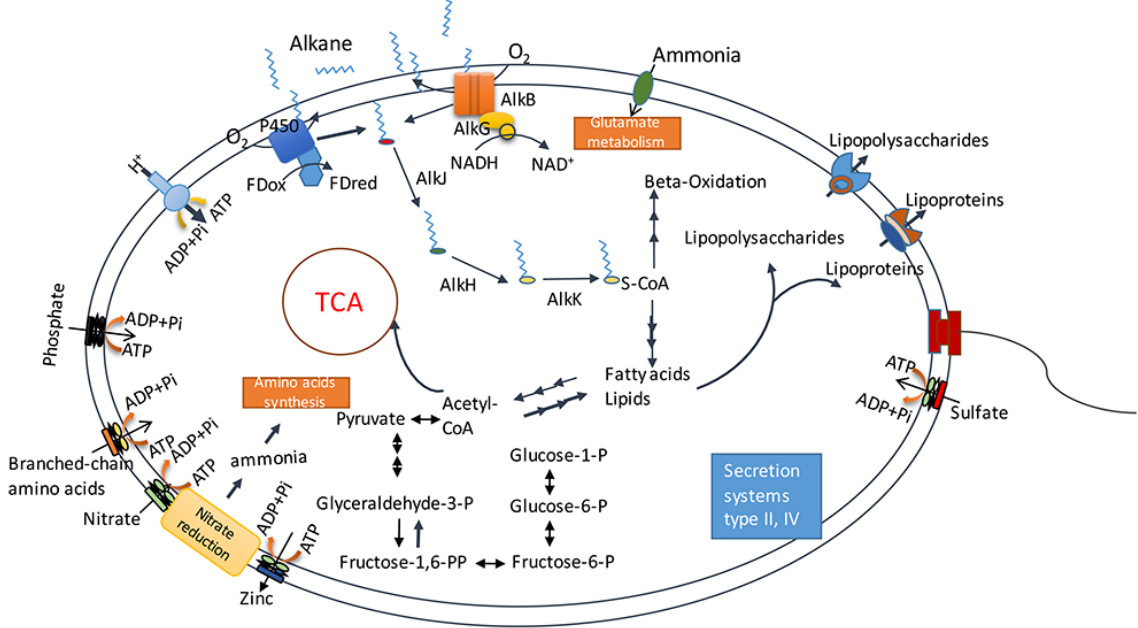
Figure 6. Schematic model of metabolism and cross-membrane transporters. The model was predicted based on the genes in the draft genome of Alcanivorax borkumensis